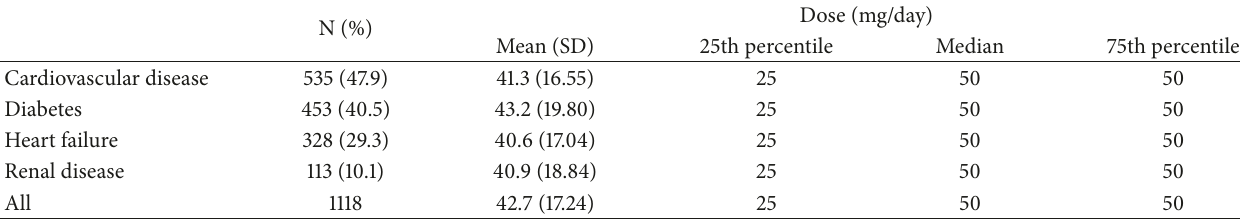
Table 5: Initial daily dose of eplerenone by comorbidities in eplerenone-na¨ıve